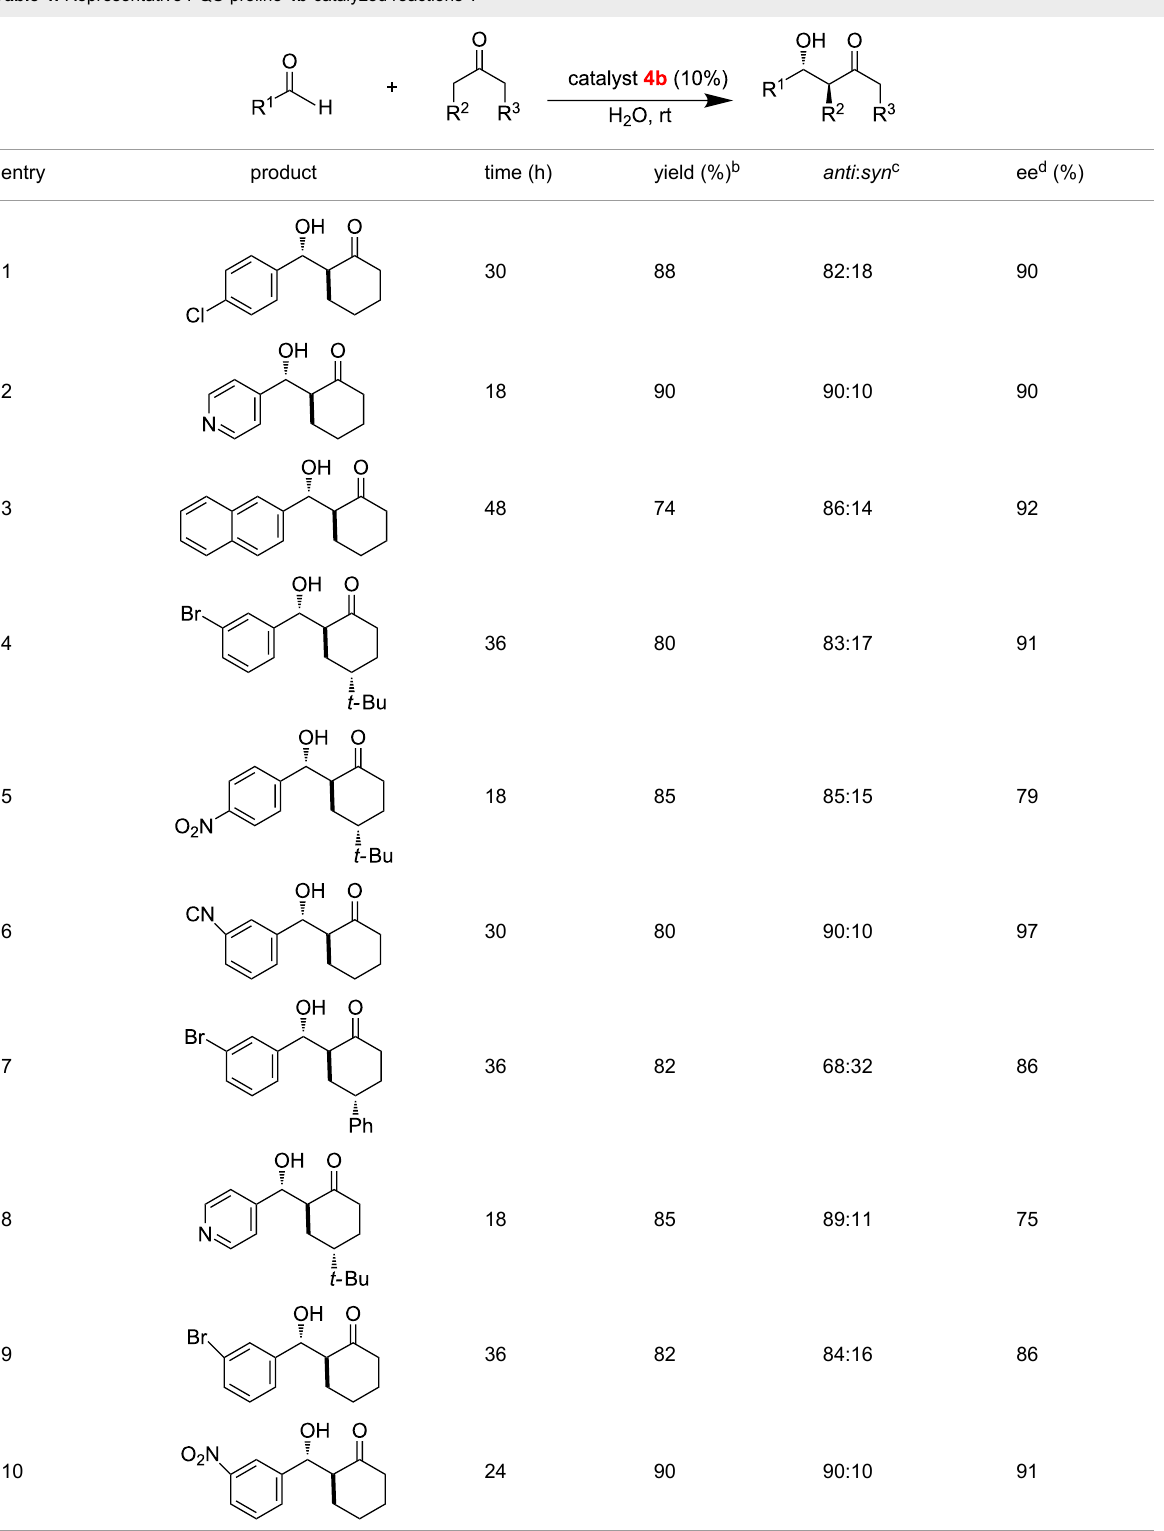
Table 4: Representative PQS-proline 4b -catalyzed reactions a